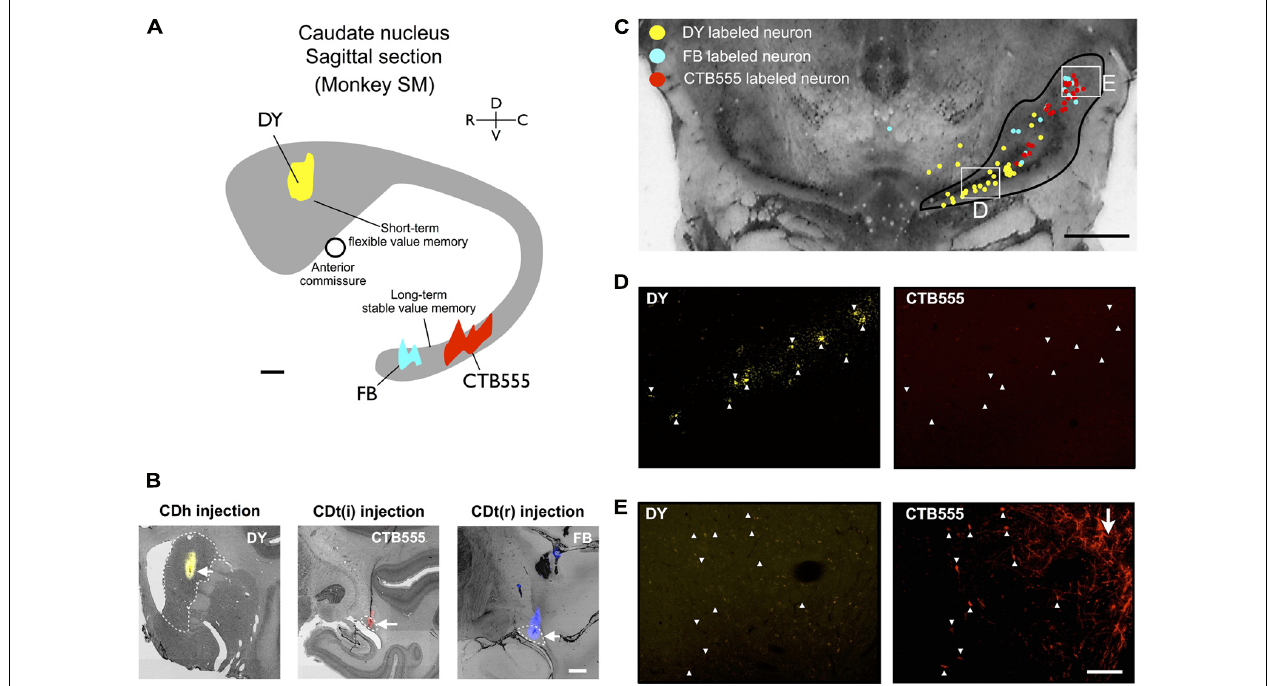
Boxed regions are examined in (D,E) . Scale bar: 5 mm. (D) DY-labeled CDh-projecting neurons (left, indicated by white arrowheads) were not labeled with CTB555 (right). (E) CTB555-labeled CDt-projecting neurons (right) were not labeled with DY (left). White arrow indicates axon terminals of CDt neurons labeled with CTB555 anterogradely (right). Scale bar: 200 μ